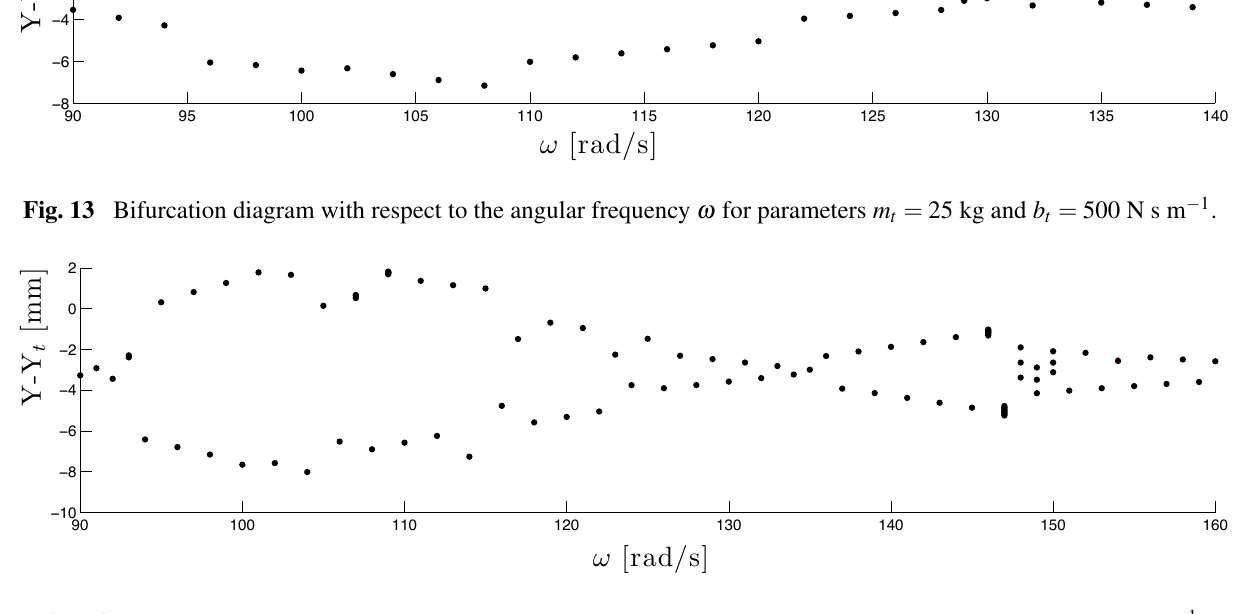
Fig. 14 Bifurcation diagram with respect to the angular frequency ω for parameters m t = 25 kg and b t = 0 N s m − 1